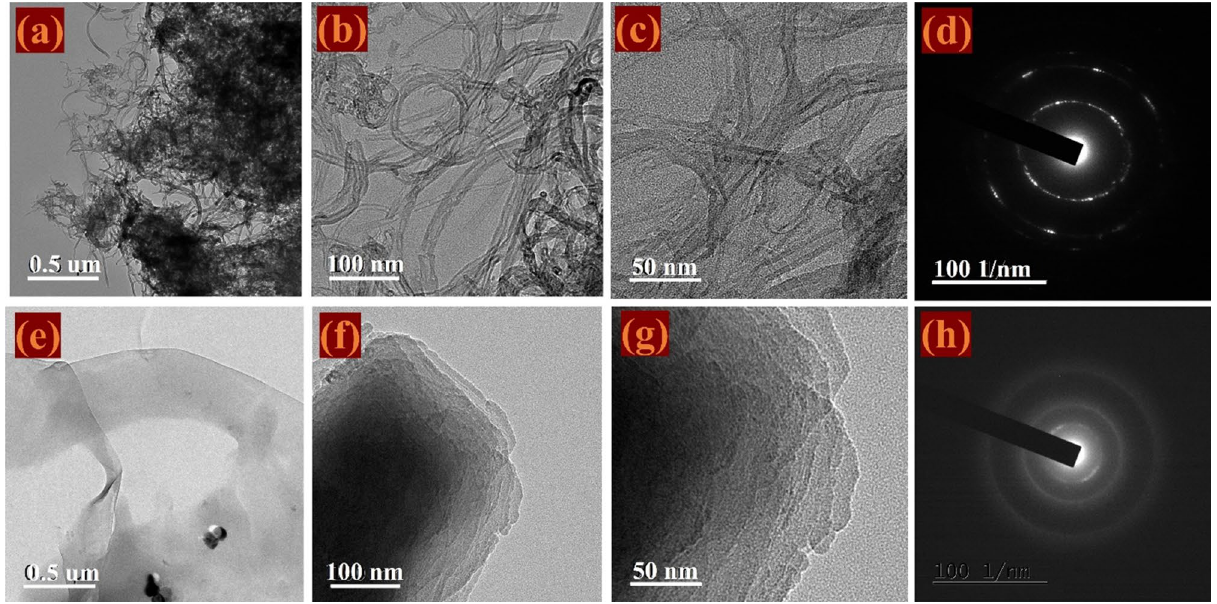
Figure 7. TEM images in different magnifications and SAED analysis of composites, respectively: ( a – c ) and ( d ) for N-MWCNT; ( e , f ) and ( h ) for